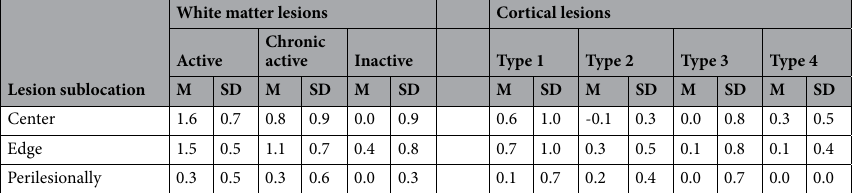
Table 4. LGMN scores in human brain tissue samples. M mean, SD standard deviation, Type 1 leucocortical, Type 2 subpial, Type 3 intracortical, Type 4 throughout cortex.